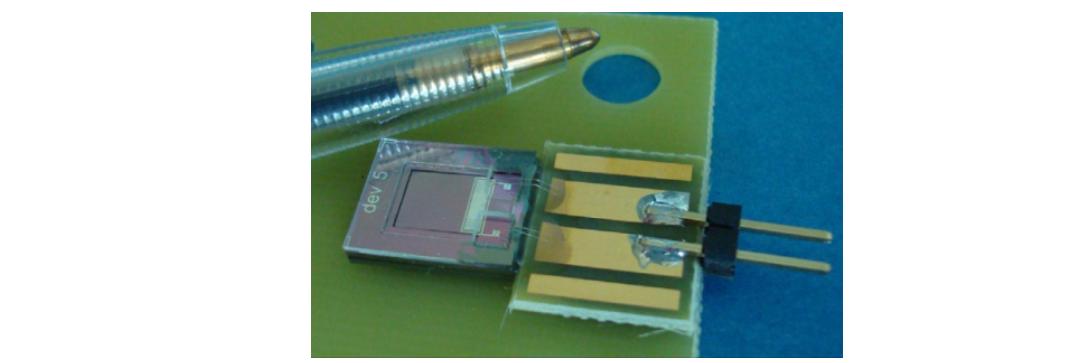
Figure 1: Piezoelectric generator [10]: 10x10x1mm 3 size, 60 μ W output power in resonance condition (572 Hz) and 2g acceleration. Magnetic inductive energy harvesters